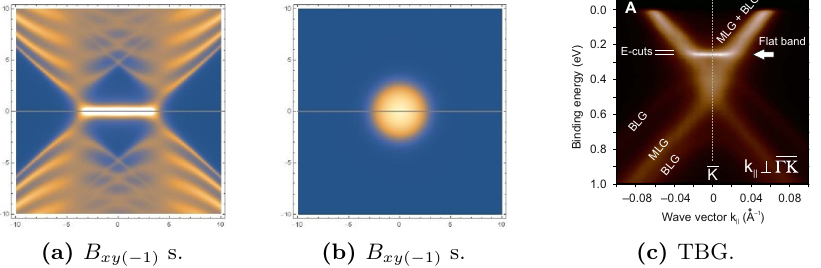
Figure 2. Spectral function with 2-tensor B xy for the two flavor. (a) ω vs k x , (b) spectral function in k x , k y plane. Notice the zero mode Disk in B xy . (c) bilayer graphene with Extremely flat band